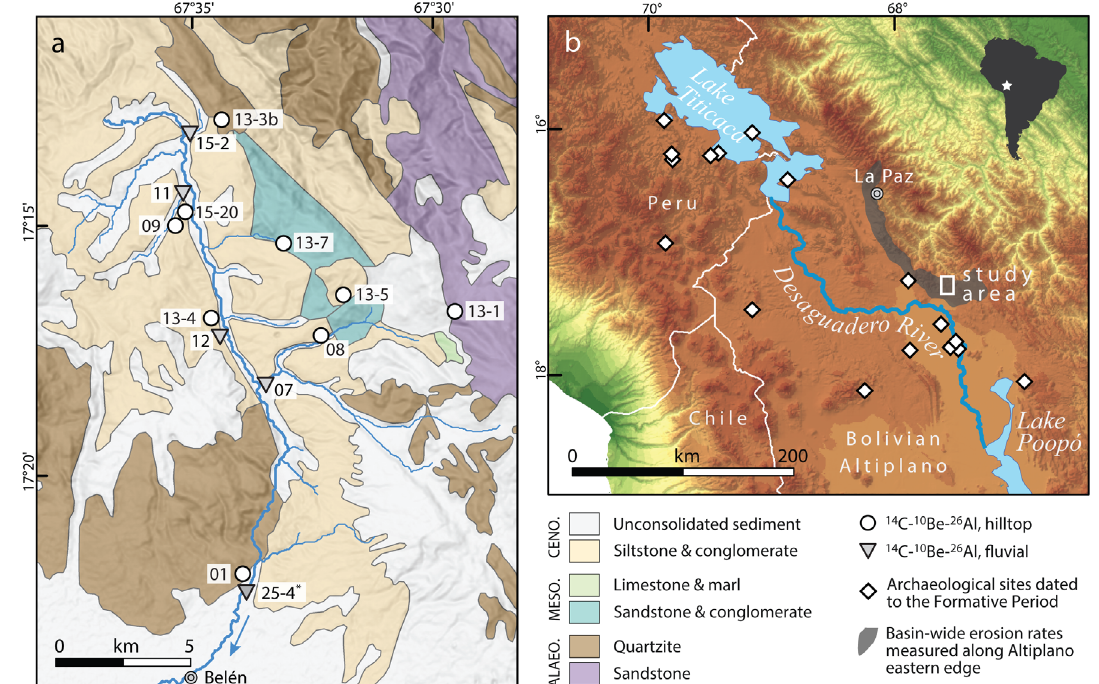
Fig. 1 Study area and sampling locations in the southern Titicaca Basin, central Altiplano. a The Belén River draining southwards from the Altiplano ’ s eastern rim and the locations of our samples; sample 25-4 is from Hippe et al. 81 . Rock types are generalized according to their Palaeozoic, Mesozoic or Cenozoic age; geologic map modi fi ed after refs. 82,83 . b Southern Titicaca Basin and central Altiplano (South America top-right inset) showing study area (white square) 15 – 30 km from the Desaguadero valley; 18 regional catchments with basin-wide erosion rates (grey shading, Supplementary Table 6); and 17 archaeological sites (white diamonds) radiocarbon-dated to the start of Formative Period in the Titicaca Basin 44